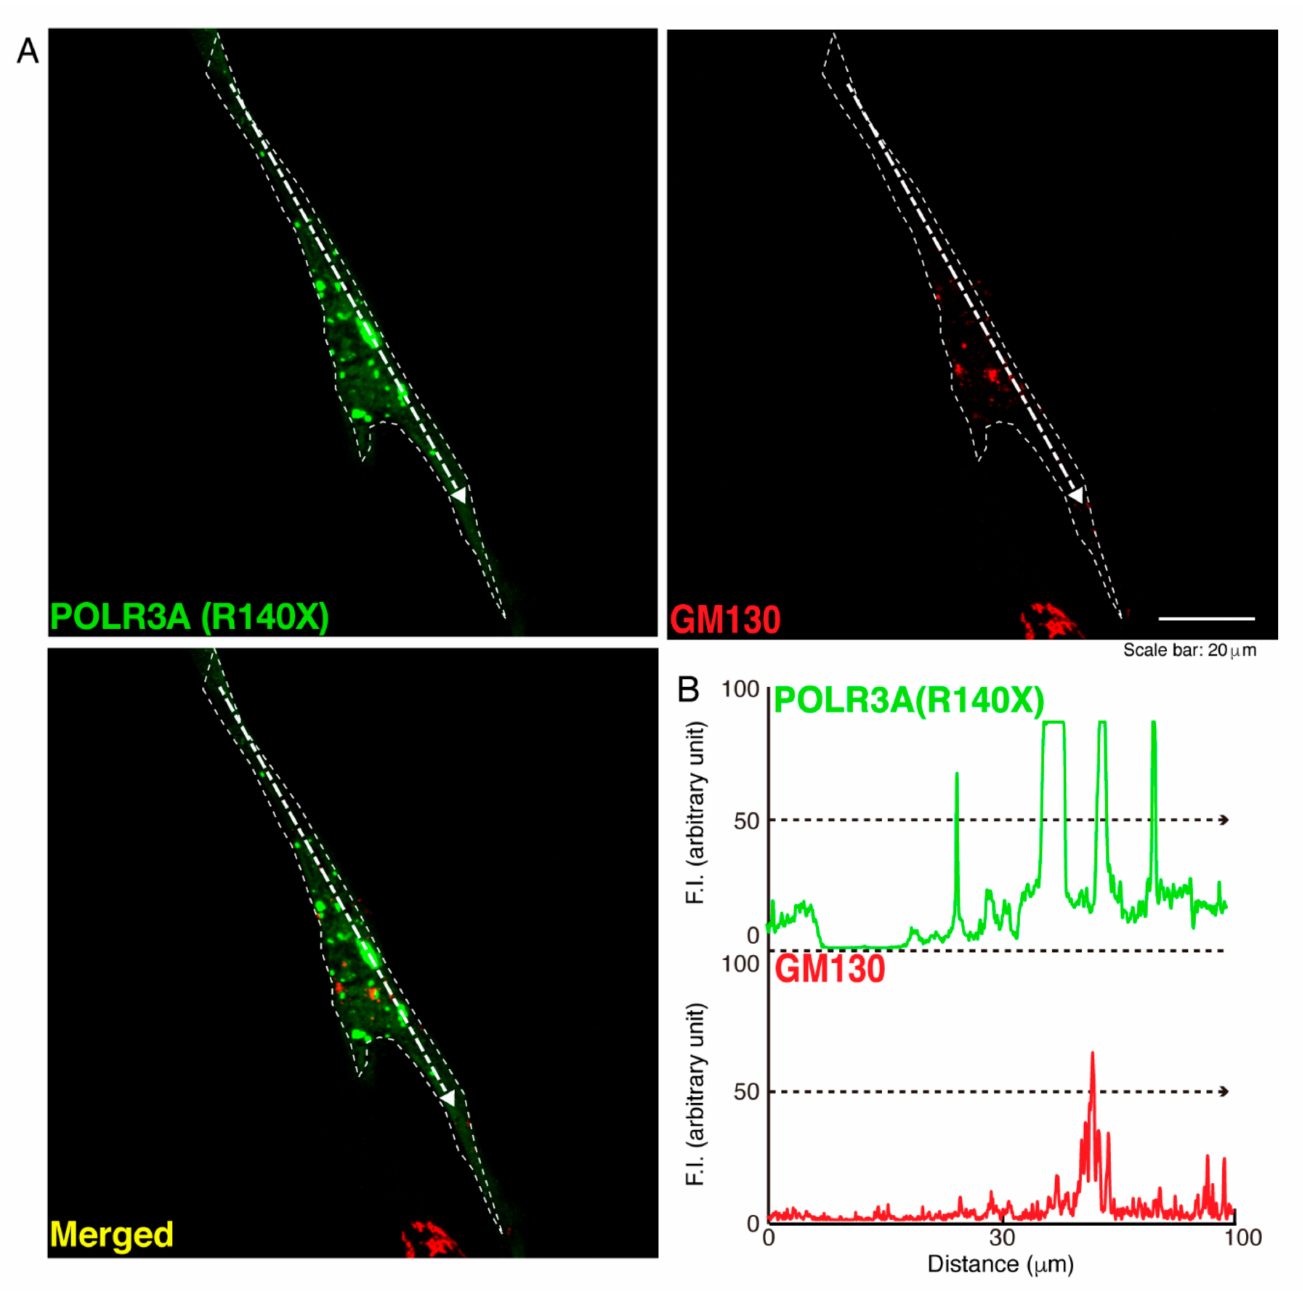
Figure 5. The POLR3A mutant proteins are not co-localized with the Golgi body in cells. ( A , B ) FBD − 102b cells were transfected with the plasmid encoding the POLR3A R140X construct (green) and stained using an antibody against the GM130 antigen (red). Scan plots were performed along the white dotted lines in the direction of the arrows in the color images (green and red as well as merged images). Graphs showing the fluorescence intensities (arbitrary units) along the white dotted lines in the direction of the arrows can be seen in the right bottom panels (black dotted